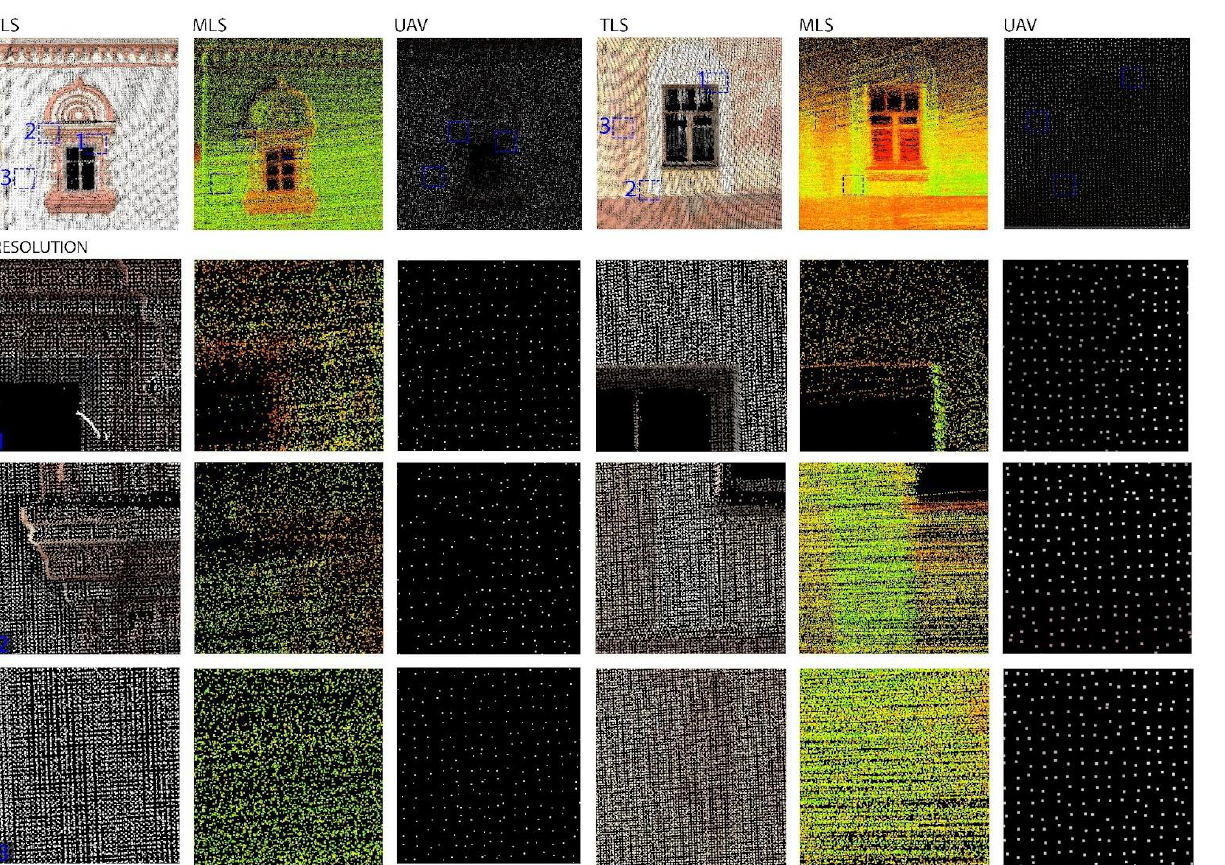
Figure 7 . Comparison of resolution quality in spatial data acquired during the urban survey campaign in Solikamsk (2019): two portions from architectural surfaces have been compared, both from an Heritage built object (on the left) and an urban unit (on the right). For each of them, the resolution of detail for the opening bourder (1), the decorative apparatus (2) and the vertical surface (3) has been analysed, considering the different instrumental applications and point clouds’